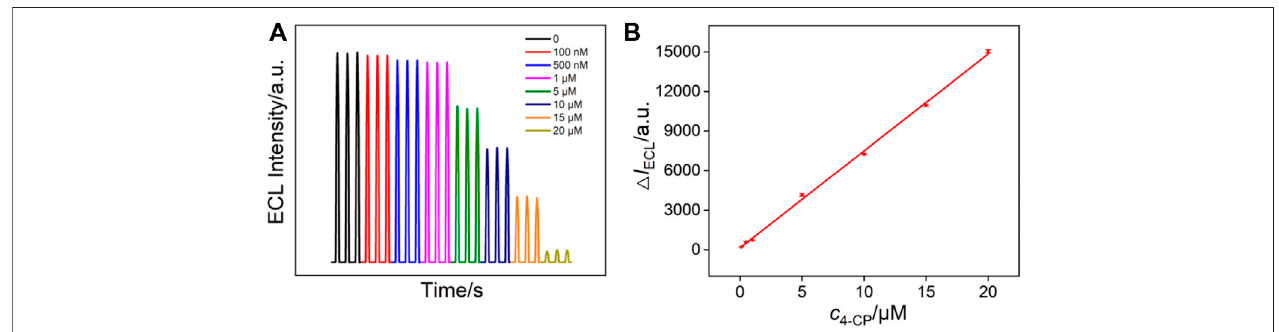
FIGURE 7 | (A) ECL intensity of 10 μ M Ru (bpy) 32+ in the presence of different concentrations of chlorpheniramine. (B) The linear dependence between the ECL intensity and the concentration of chlorpheniramine.